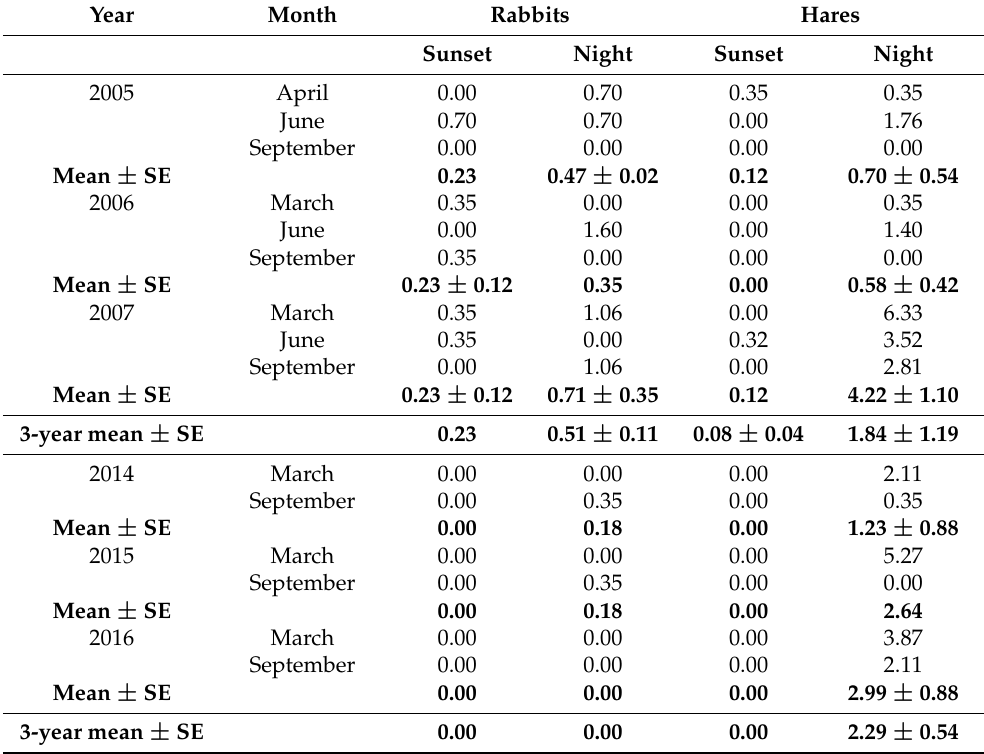
Table A1. Ecotone